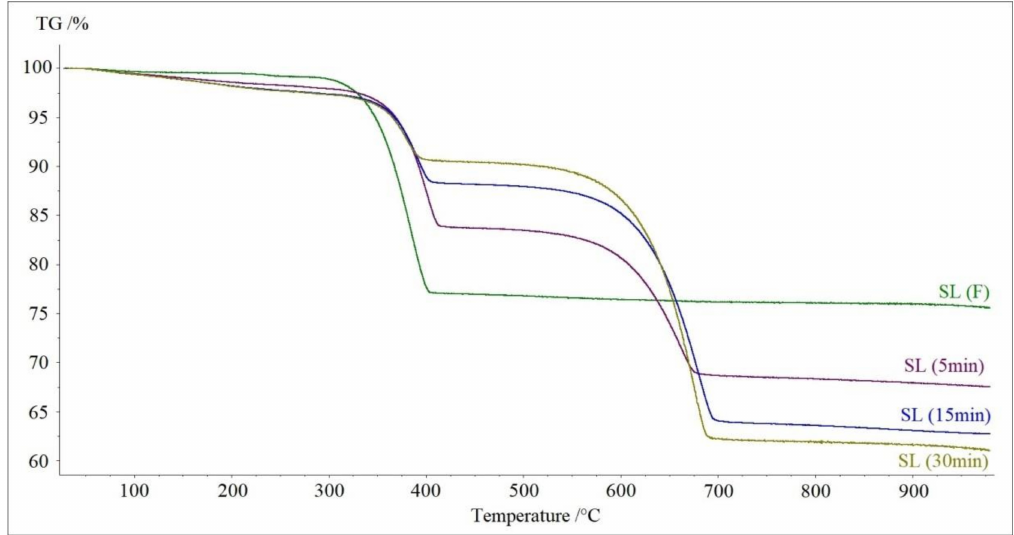
Figure 4. TG curves of decomposition of SL (F) sample and samples after carbon dioxide absorption: SL (5 min), SL (15 min) and SL (30 min) in